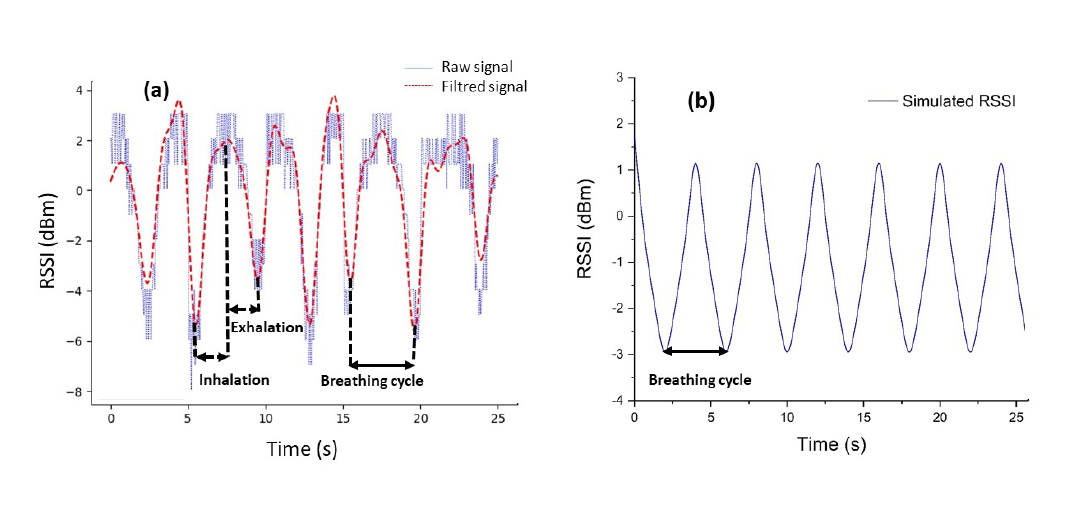
Figure 8. ( a ) Breathing signal from received signal strength indicator (RSSI) measurements (blue) and the filtered signal using a Butterworth filter (red). ( b ) Simulated RSSI calculated for the SHB during the